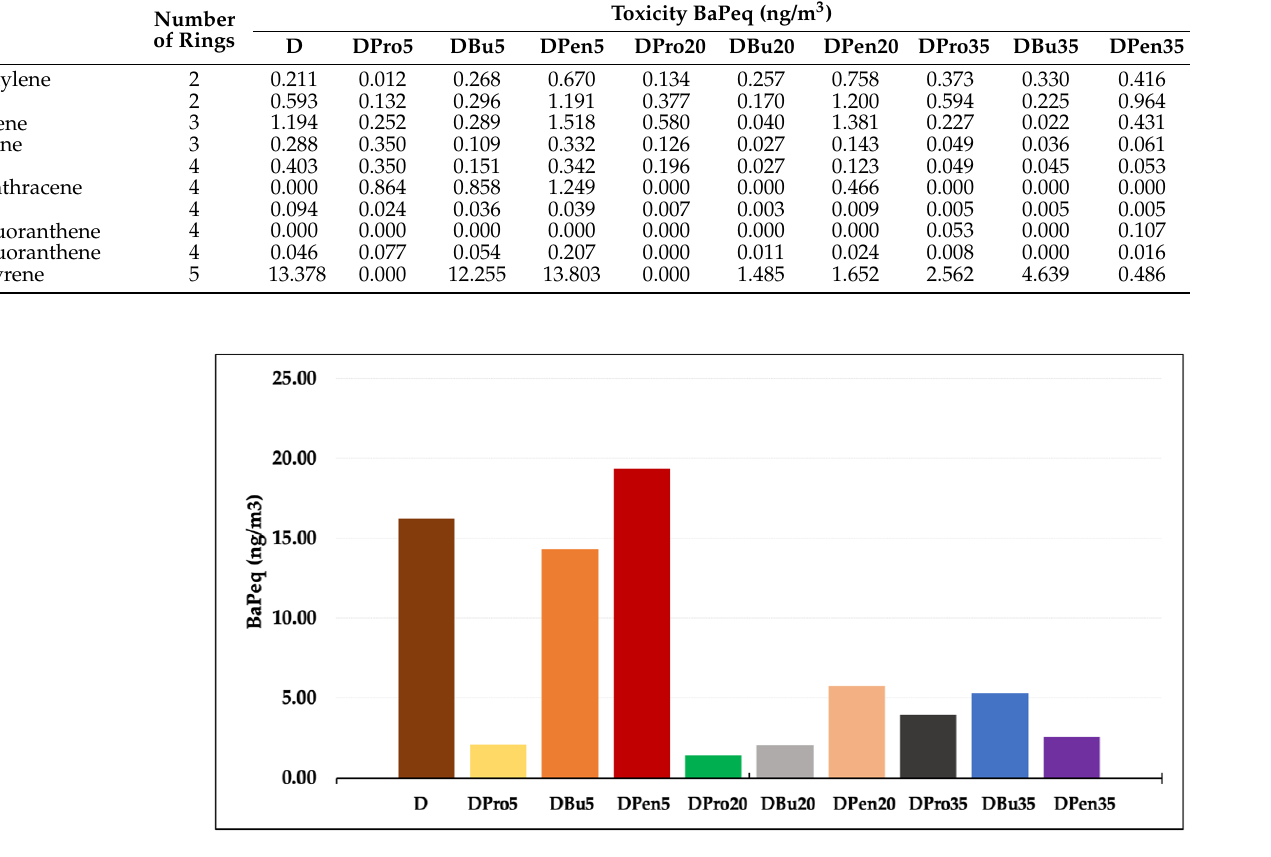
Figure 7. The toxicity distribution of test fuels.